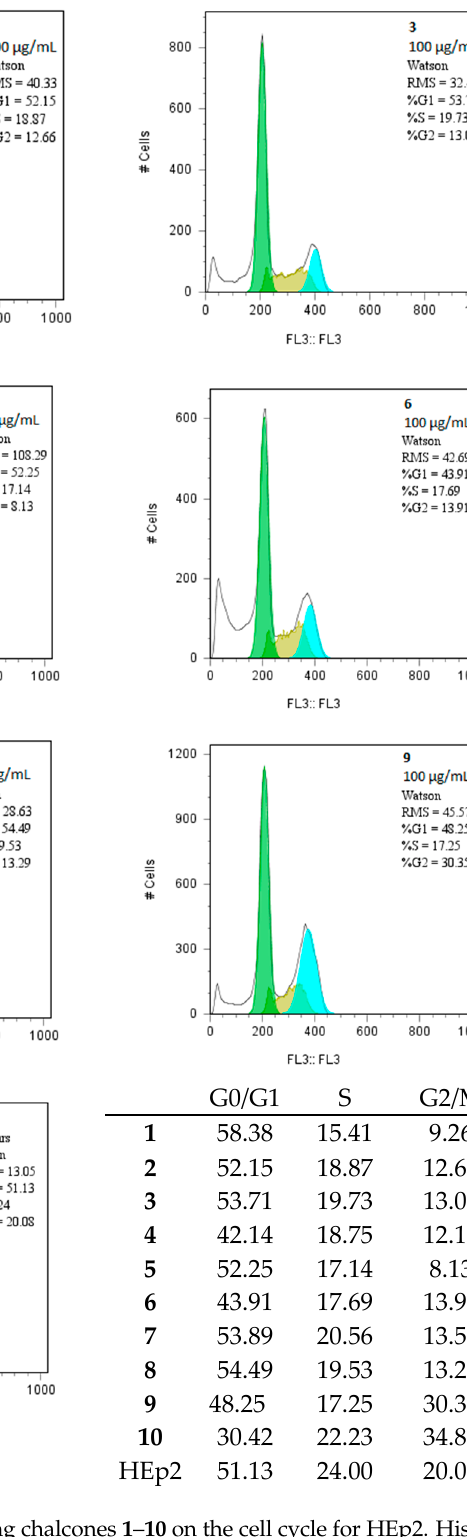
Figure 4. The effect of the azulene-containing chalcones 1 – 10 on the cell cycle for HEp2. Histograms show the changes in cellular DNA content after treatment with 100 µ g/mL azulene-containing